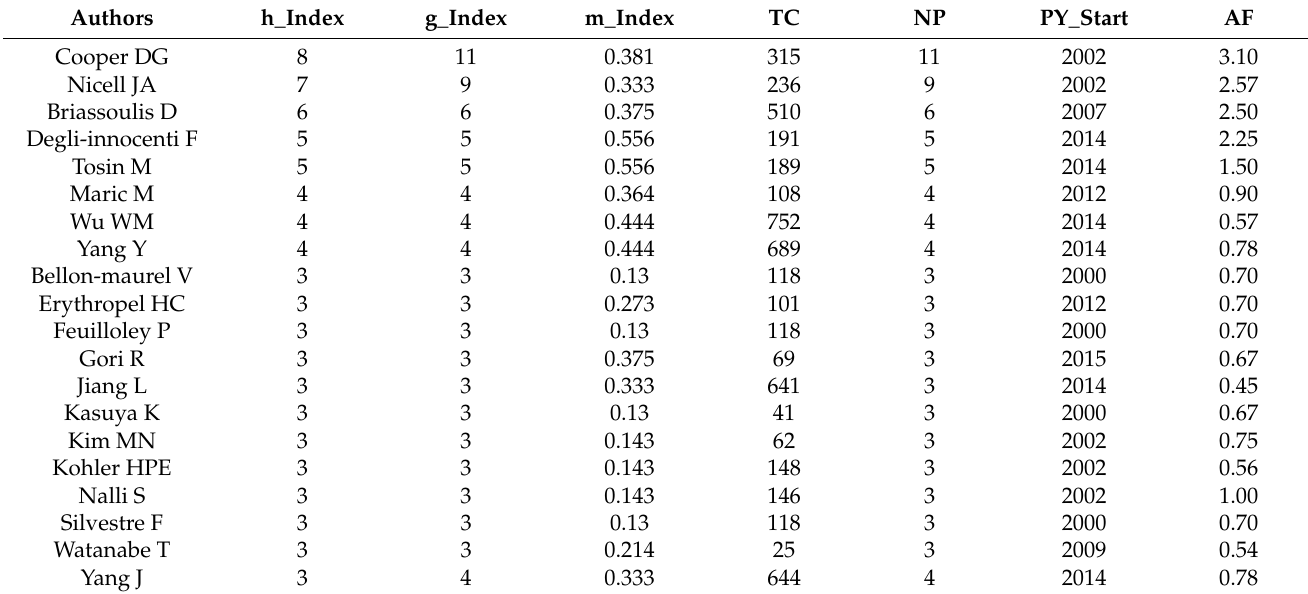
Table 3. Top relevant authors in biodegradation-of-plastics-related research between 2000 and 2021.